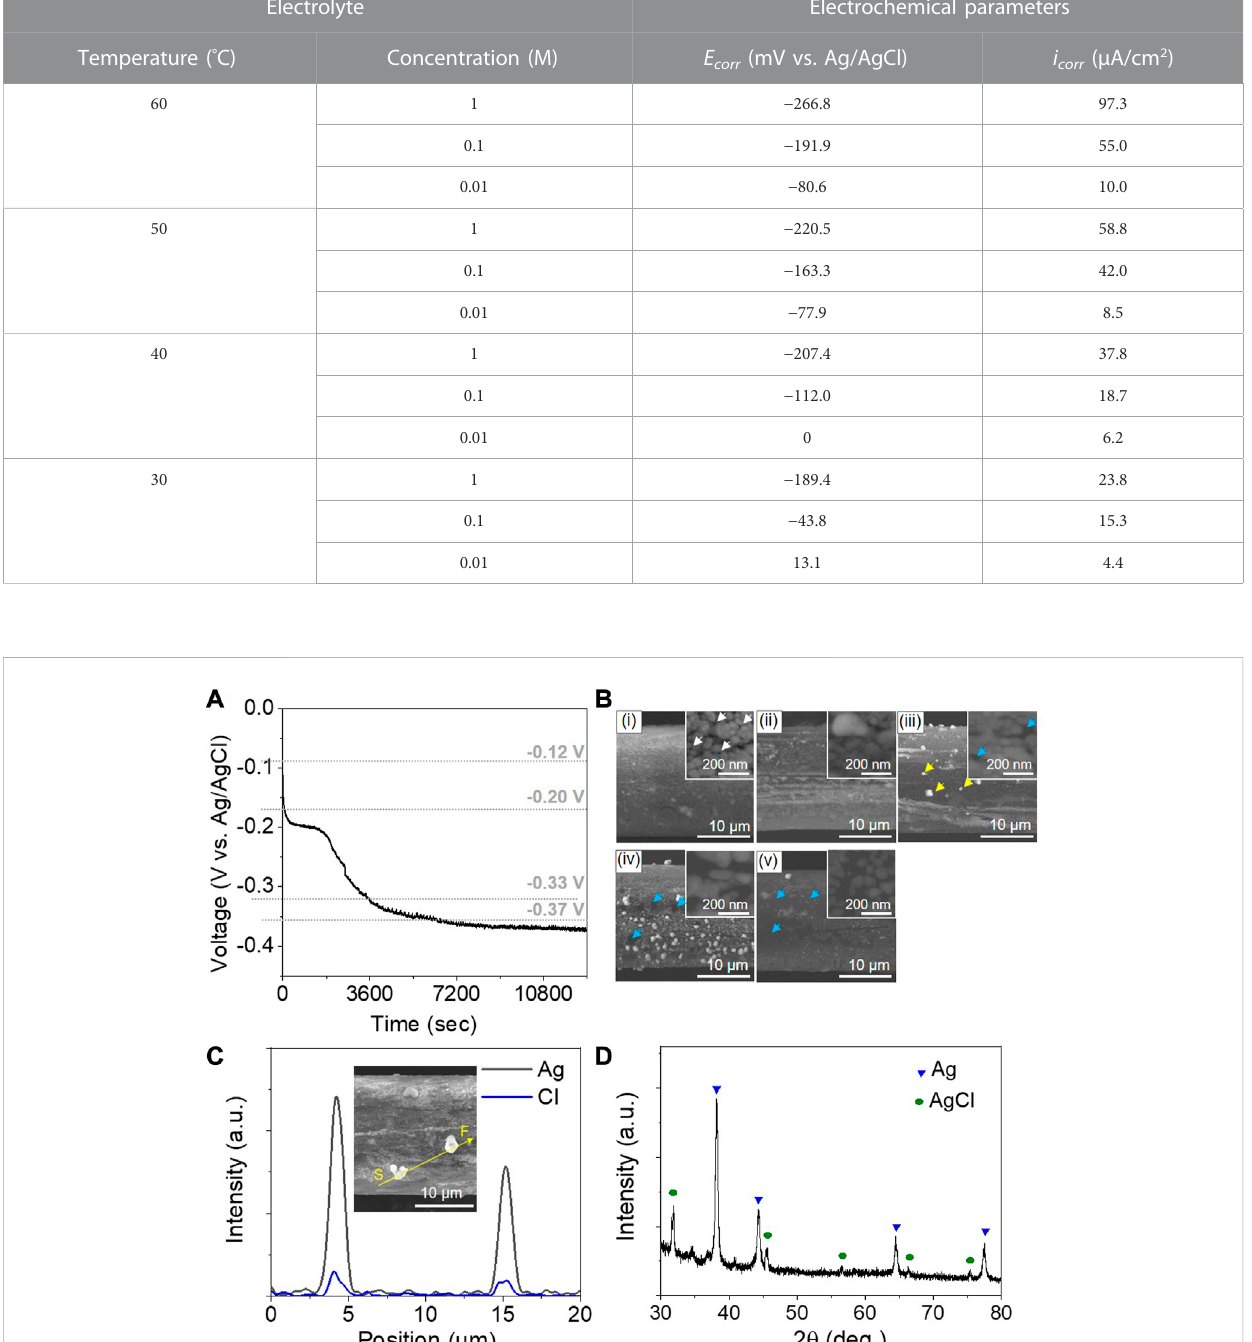
TABLE 1 Electrochemical parameters obtained from the potentiodynamic polarization curves in Figure 2. Electrolyte Electrochemical parameters